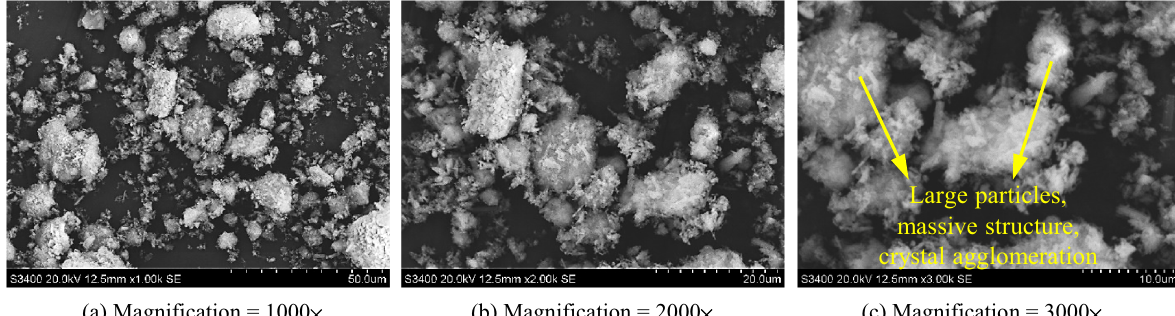
Fig. 6 Morphological characteristics of high-water material with a water-to-cement ratio of 1.6:1